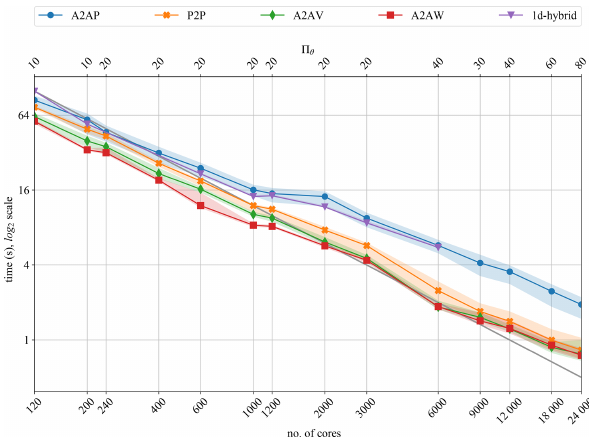
Figure 6. Strong scalability for the (cid:96) transposition, LU decomposi- tion, and backward substitution for the dynamo